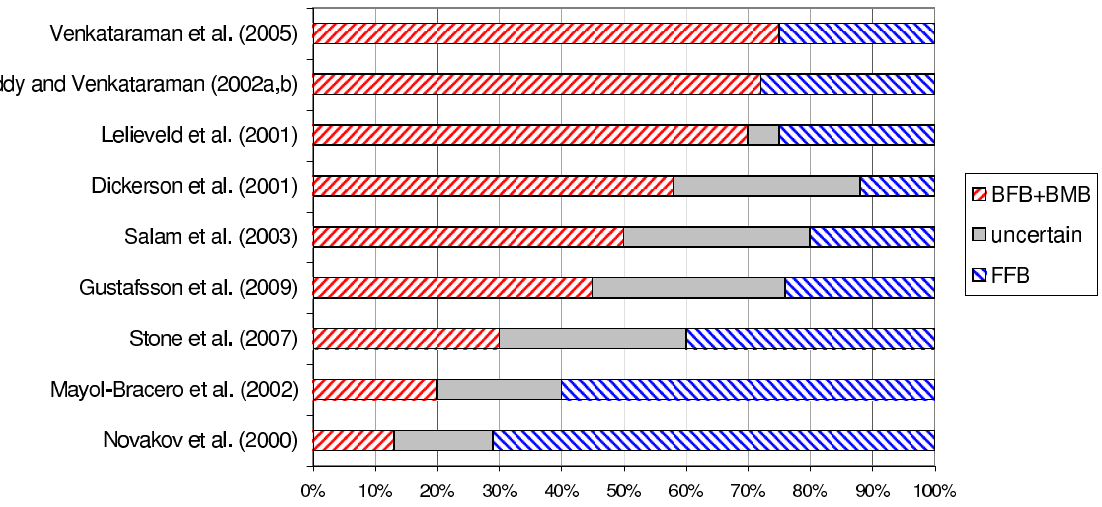
Fig. 4. Relative contributions (in %) of biofuel burning (BFB) plus biomass burning (BMB) versus fossil fuel burning (FFB) processes, either to the total BC emissions from India, or to the southern Asian outflow, depending on the study; the uncertainty in the range given in each study is represented by the gray shaded area; see the text for more information on the individual